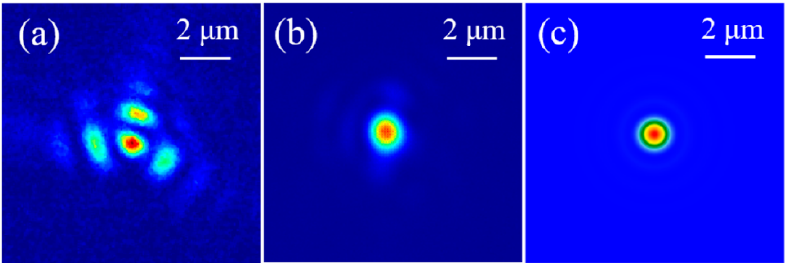
Figure 8. Focal spot images: ( a ) before correction, ( b ) after WF correction, ( c ) diffraction quality for an f/1.1 parabolic